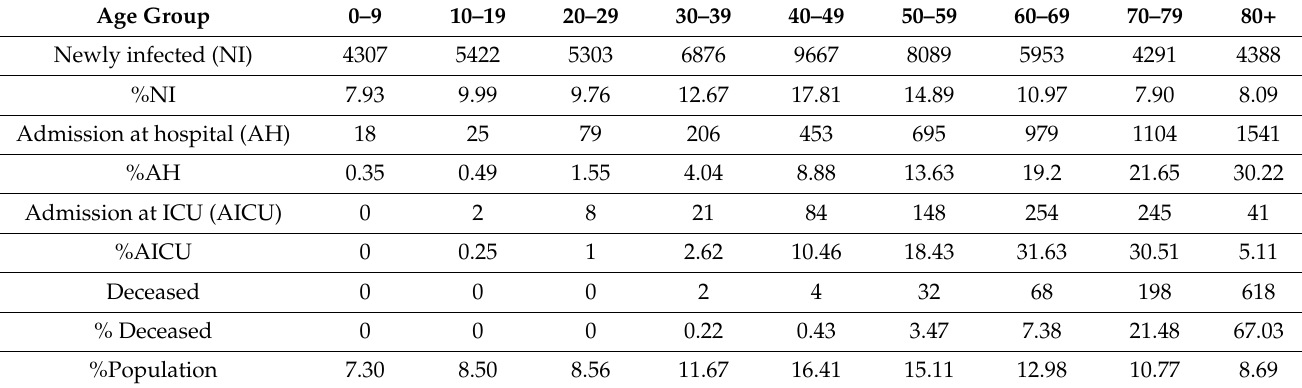
Table 4. Data corresponding to the period 1 January 2021 to 1 April